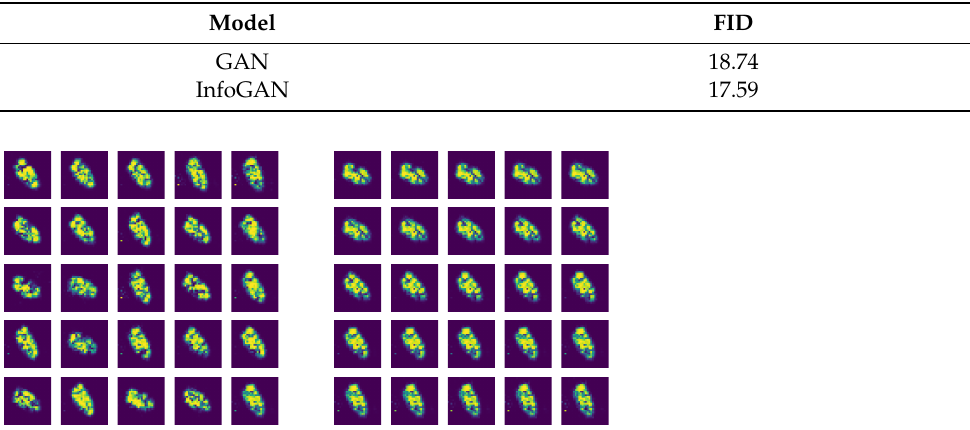
Table 1. The FID of images generated by two GANs and training images.